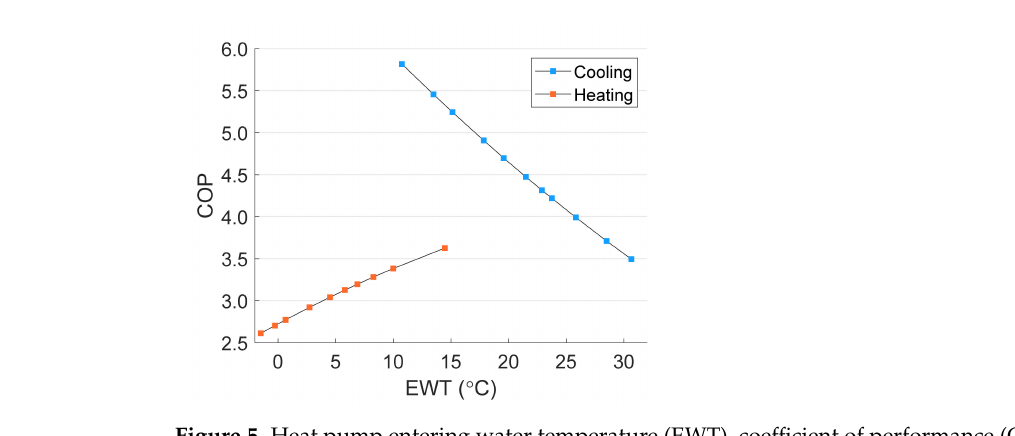
Figure 5. Heat pump entering water temperature (EWT)–coefficient of performance (COP) curve for heating and cooling